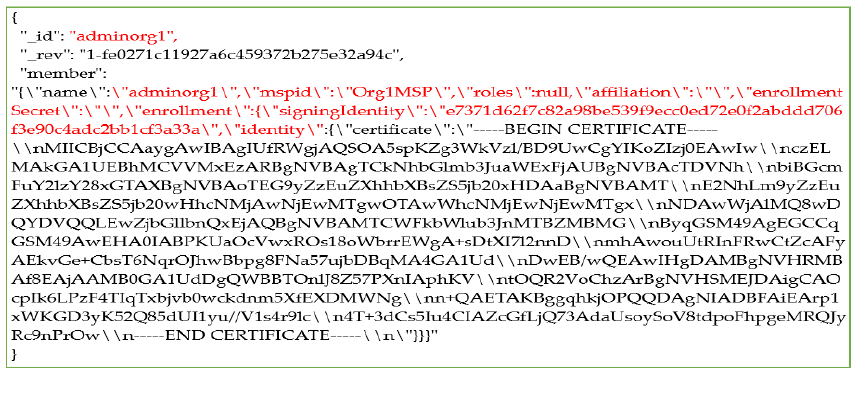
Figure 8. Devices registered on Fabric organizations.